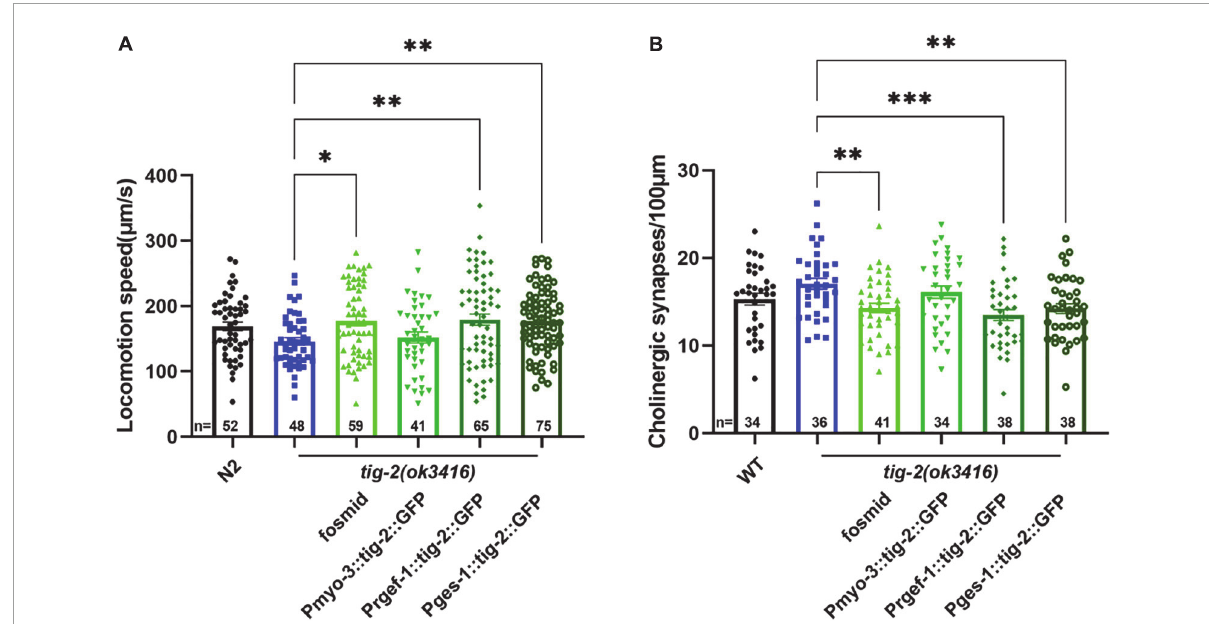
FIGURE4 Neuronal or intestinal expression of tig-2 abolishes locomotion speed defects and decreased density of cholinergic synapse in tig-2 ( ok3416 ). (A) Locomotion speed on day 3 in tig-2 ( ok3416 ) mutants and tissue-specific tig-2 rescue alleles. Green columns indicate transgenic lines that carry plasmids restoring the expression of tig-2 in muscle cells ( p = 0.9768), neurons ( p = 0.0060), intestine ( p = 0.0089) and globally rescue ( p = 0.0139). Neuronal TIG-2 and intestinal TIG-2 abolish the decrease in locomotion speed in the mutant. (B) Qualification of the density of cholinergic synapse in tig-2 ( ok3416 ) mutants and tissue-specific tig-2 rescue alleles. Neuronal tig-2 ( p = 0.0003) and intestinal tig-2 ( p = 0.0062) suppress the increase of presynaptic puncta. p -values were calculated by one-way ANOVA with multiple comparisons. Error bars represent SEM. ∗ p < 0.05, ∗∗ p < 0.01, ∗∗∗ p <